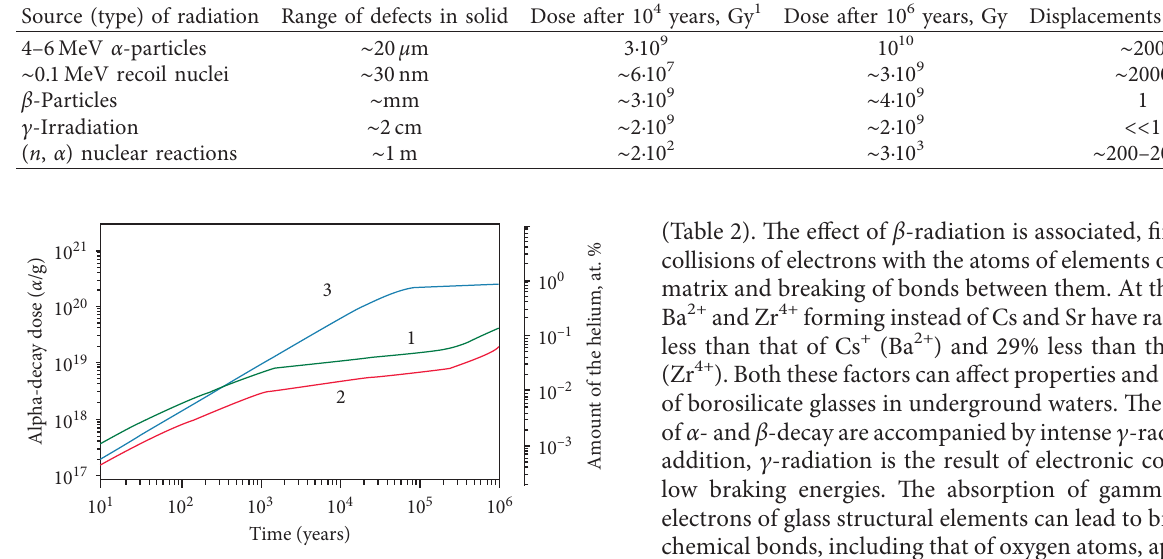
Figure 2: Dynamics of cumulative α -decay events per gram and helium accumulation in the vitrified HLW (Table 3) due to α -ir- radiation: 1, defense HLW; 2, civil HLW with a low content of minor actinides; 3, HLW with a high content of minor